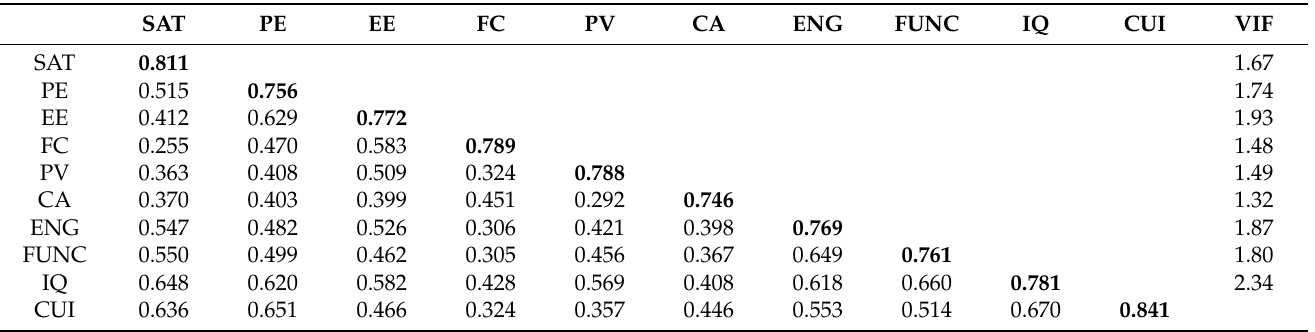
Table 4. Discriminant